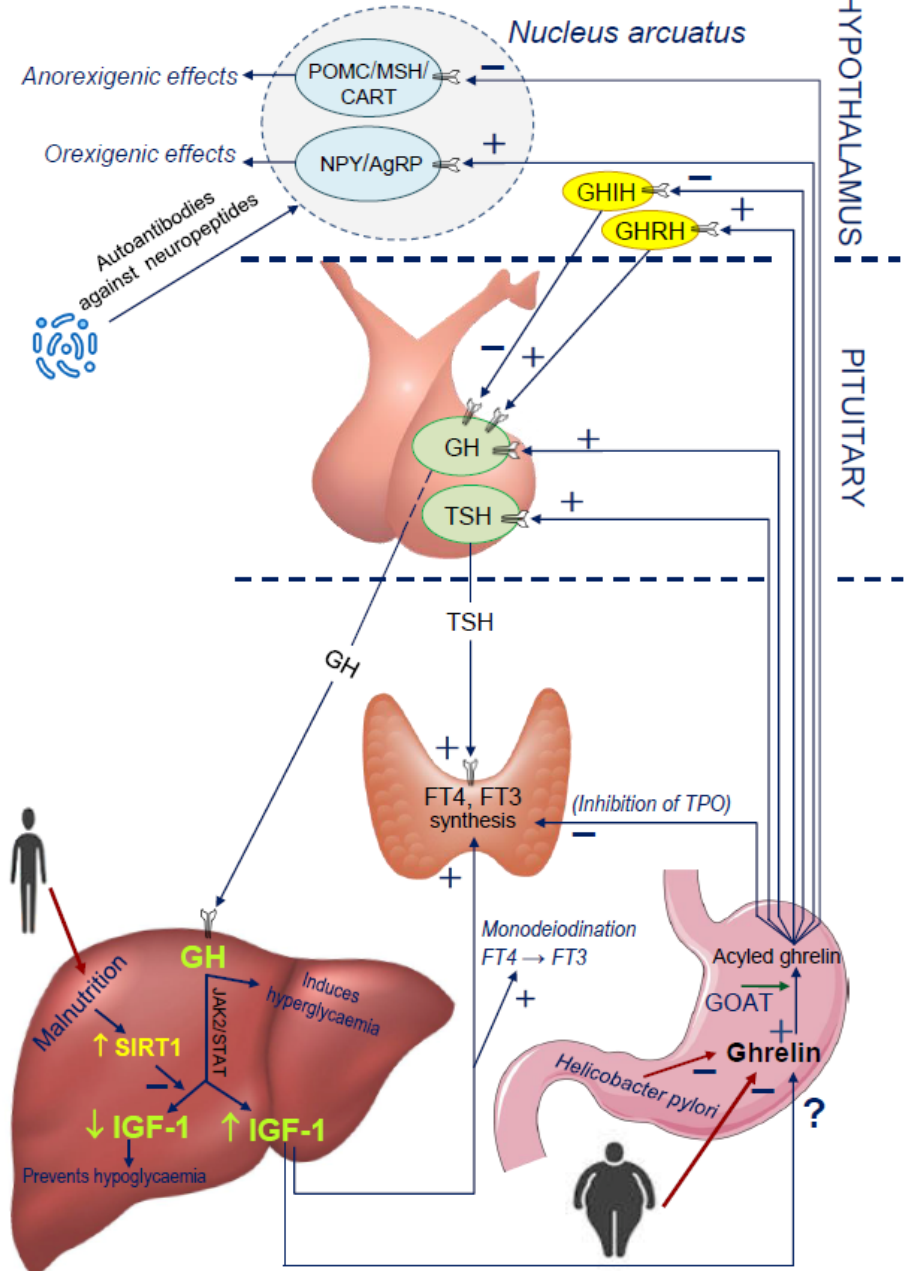
Figure 2. Reciprocal interactions among the main metabolic players (ghrelin, IGF-1) and TSH, thyroid hormone axis in the regulation of GH secretion. AgRP—Agouti-related peptide, CART—cocaine and amphetamine regulated transcript, FT3—free triiodothyronine, FT4—free thyroxine, GH—growth hormone, GHIH—growth hormone inhibiting hormone, GHRH—growth hormone releasing hormone, GOAT—ghrelin O-acyl transferase, IGF-1—insulin-like growth factor 1, MSH— melanocyte-stimulating hormone, NPY—neuropeptide Y, POMC—proopiomelanocortin, SIRT1— sirtuin 1, TPO—thyroid peroxidise, TSH—thyroid stimulating hormone.